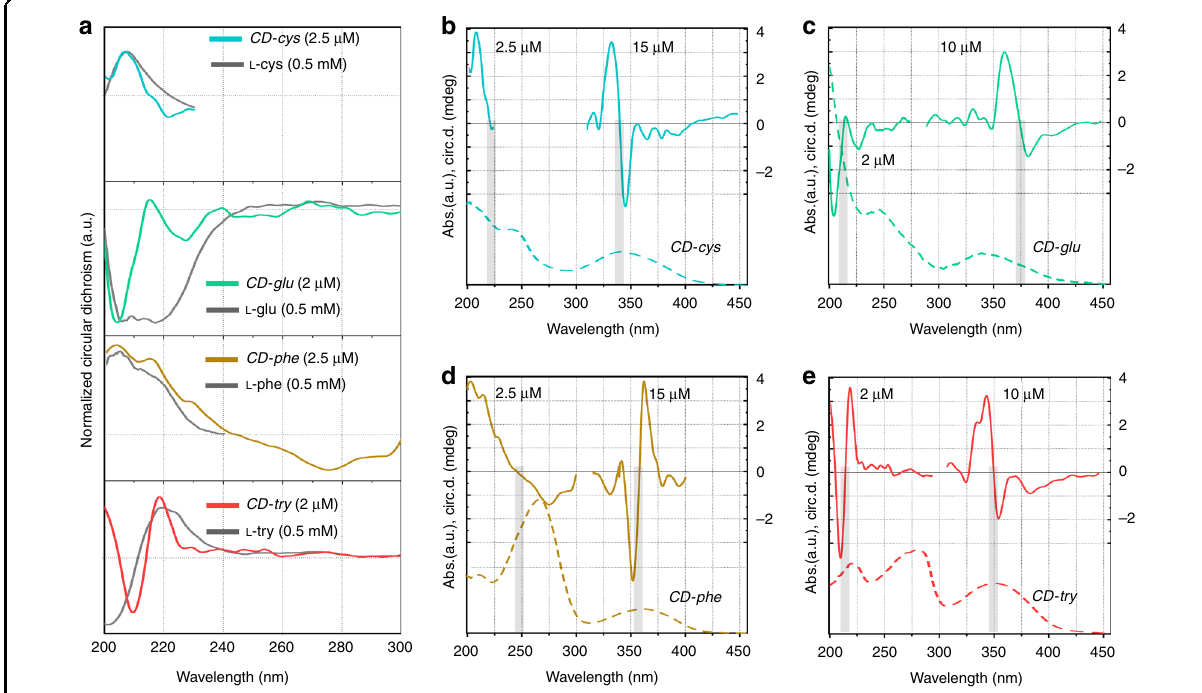
Fig. 5 Chiroptical properties of CDs. a Comparison of normalized circular dichroism spectra of the four precursor molecules (gray lines) with those of the chiral CDs in the UV spectral region; concentrations of CDs and their precursors are given in brackets. The dashed line shows the zero level. b – e Absorption spectra (dashed lines) and circular dichroism (solid lines) spectra of four chiral CD samples: b CD-cys , c CD-glu , d CD-phe , and e CD-try . The values of the circular dichroism signals are given in mdeg on the right side of each graph. Gray rectangles emphasize the sign change in the circular dichroism spectra. Concentrations of CDs for particular regions of the circular dichroism spectra are given in b – e for clarity (see text for